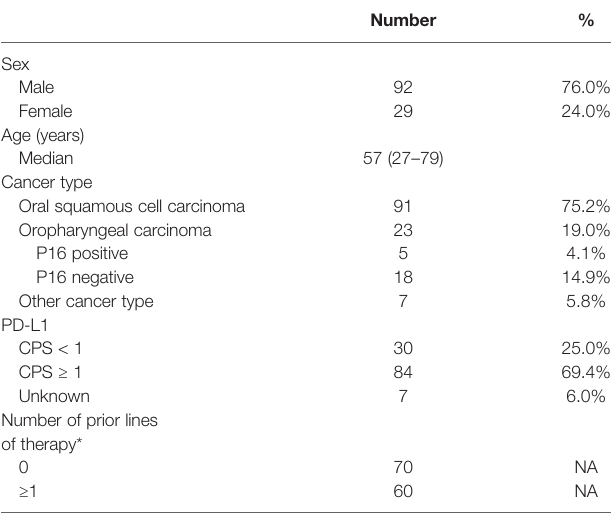
TABLE 1 | Summary of clinical